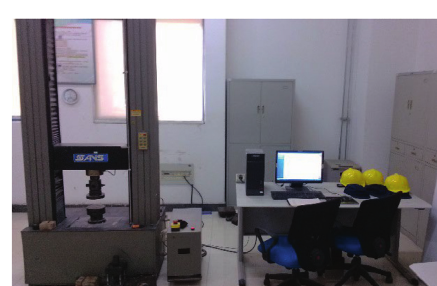
Figure 2: SANS testing system at the China University of Mining and Technology.